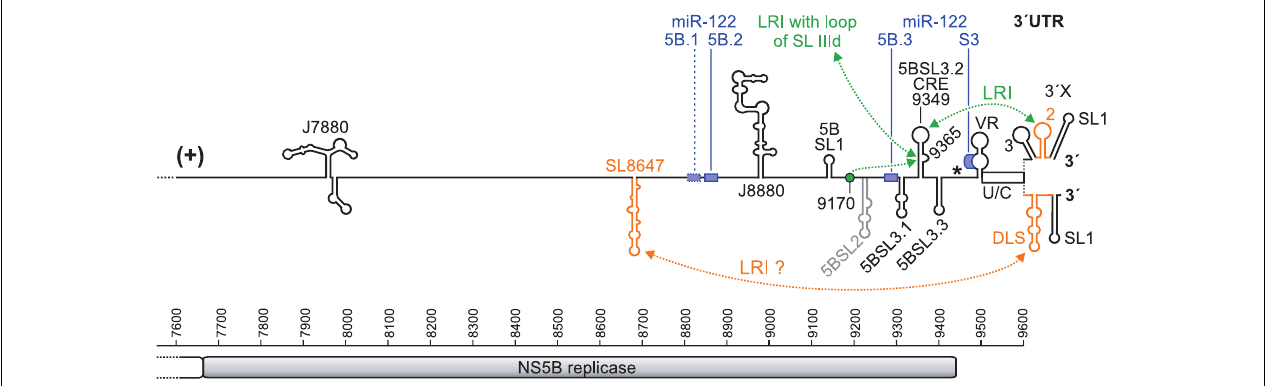
FIGURE 3 | The HCV genome 3 (cid:48) region. The NS5B sequence is shown with nucleotide numbers. The NS5B stop codon is shown by an asterisk, and the 3 (cid:48) X region is shown in its two experimentally validated alternative structures. The miR-122 binding sites are shown as blue boxes, with the first non-conserved site 5B.1 with a dotted box and the other conserved two sites in the NS5B region (5B.2 and 5B.3) and the miR-122 target site in the 3 (cid:48) UTR (S3) with solid boxes (Fricke et al., 2015). Elements suspected to be involved in RNA genome packaging are shown in orange.